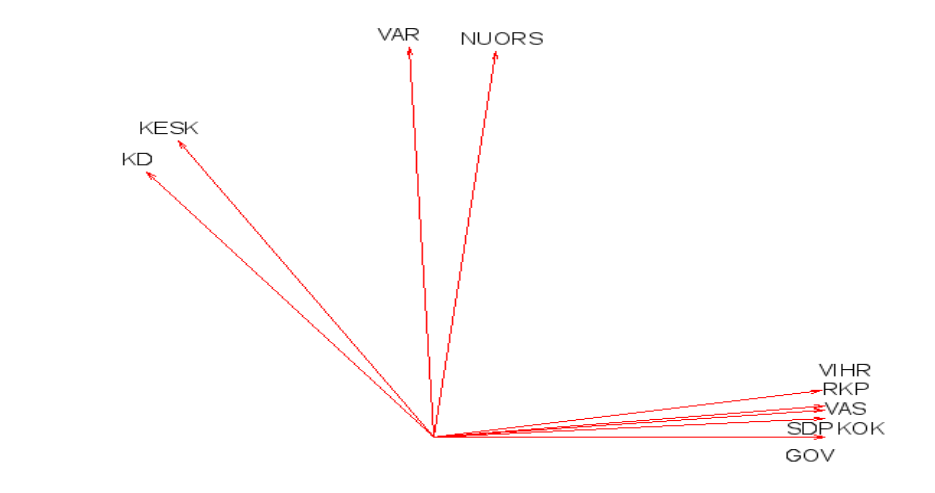
Figure 2b. Government and opposition voting during the Lipponen I government